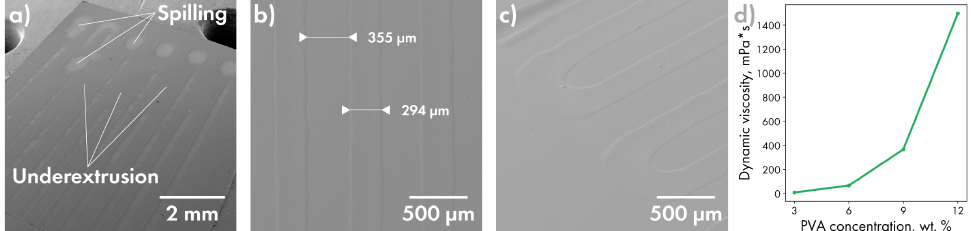
Figure 4. Selection of parameters for PVA gel preparation. ( a ) Print defects when using 6 wt % PVA solution; line width on a straight section ( b ) and on turns ( c ) using 9 wt % PVA solution; the dependence of the dynamic viscosity of PVA on the concentration ( d